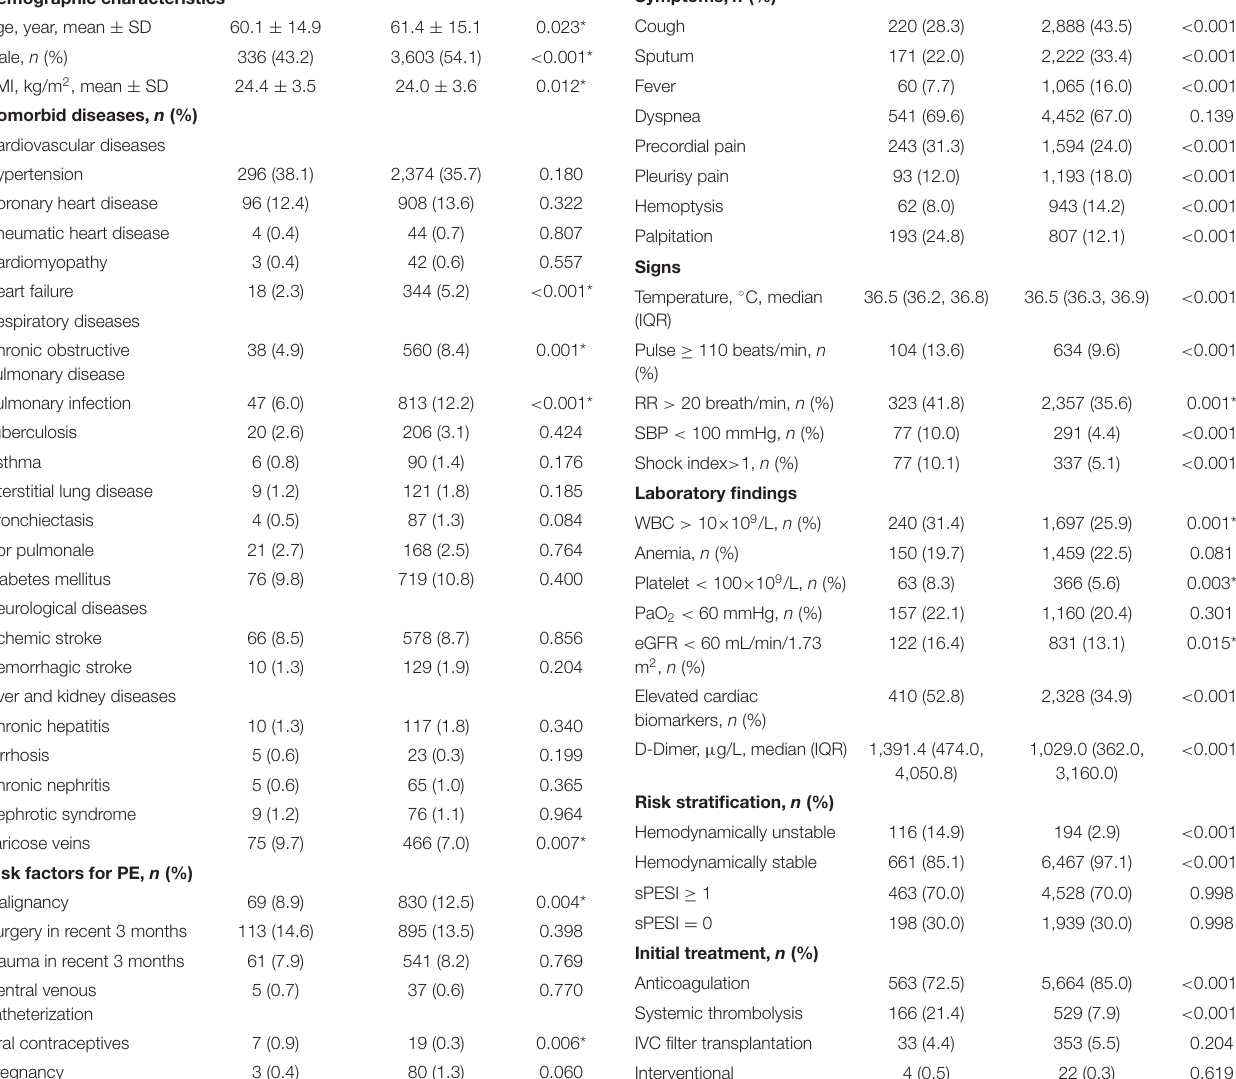
TABLE 1 | Demographic characteristics, comorbid diseases, and risk factors of patients with acute PE. Characteristics